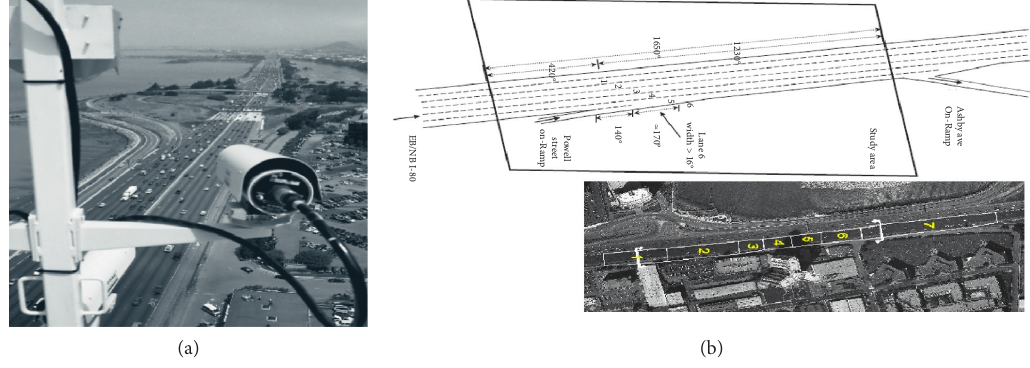
Figure 4: Summary of data acquisition area.